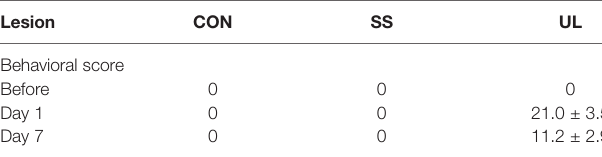
TABLE 1 | Behavioral score.